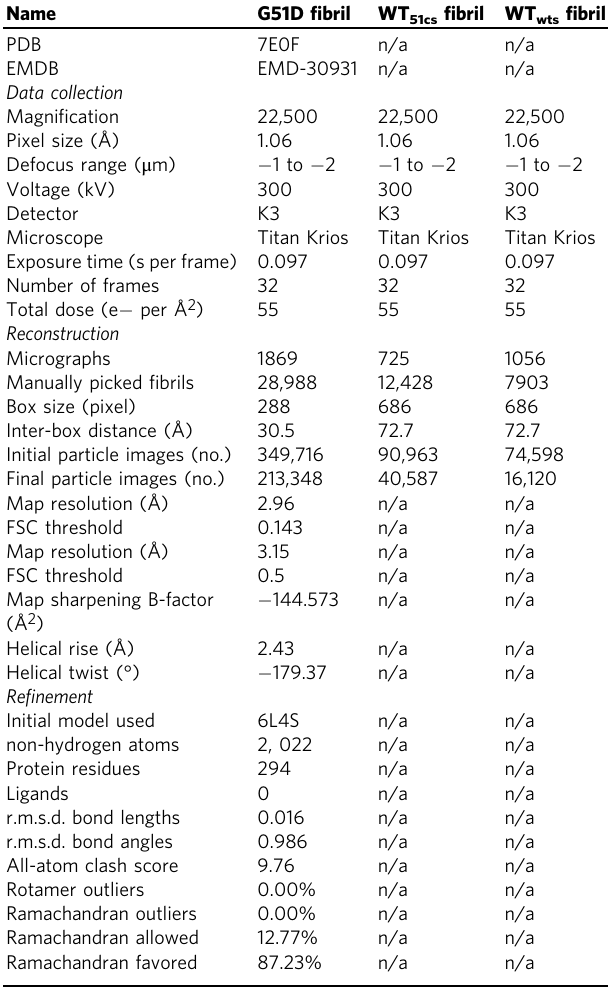
Table 1 Statistics of cryo-EM data collection and re fi